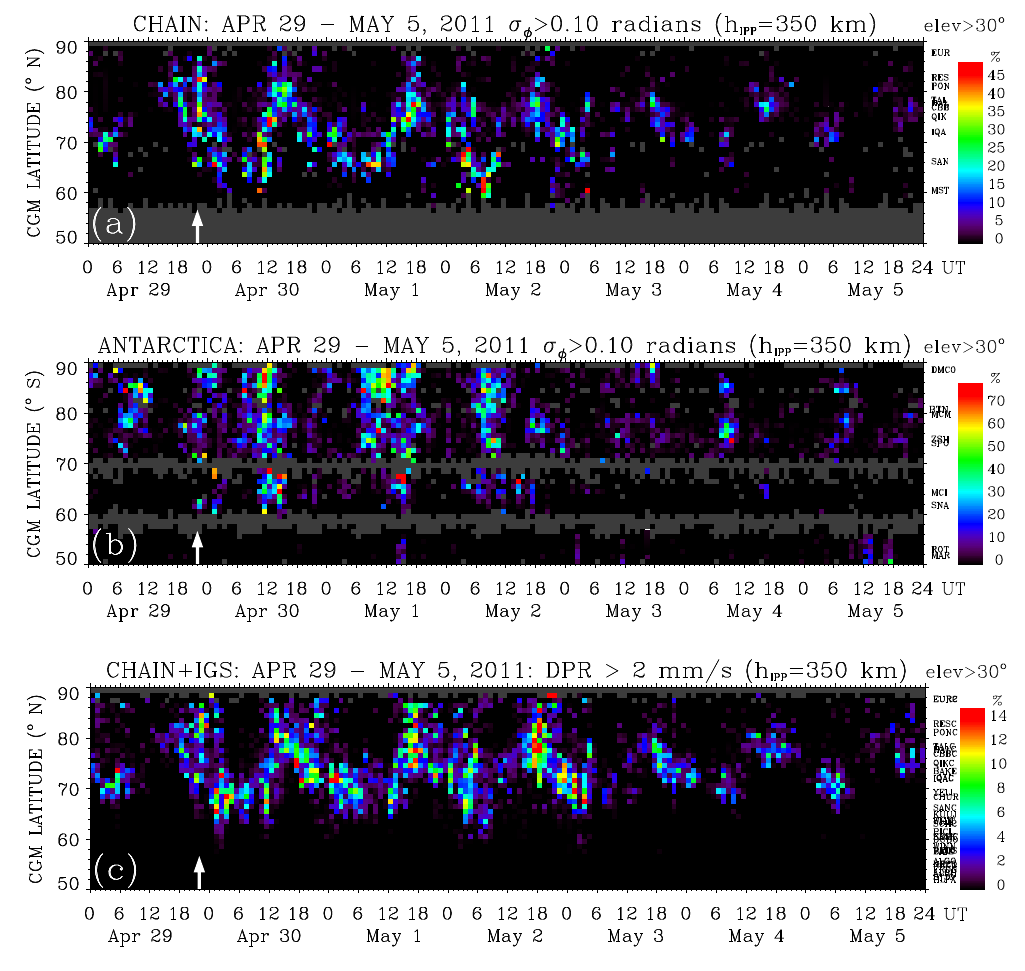
Figure 13. Phase scintillation occurrence from April 29 to May 5, 2011 as a function of CGM latitude and UT observed by (a) CHAIN and (b) GISTMs at southern high-latitudes. The occurrence of the proxy phase scintillation ( DPR > 2 mm/s) obtained from 1-Hz GPS data for (c) CHAIN and 40 more GPS receivers in the northern hemisphere. White arrows indicate the arrival time in UT of two